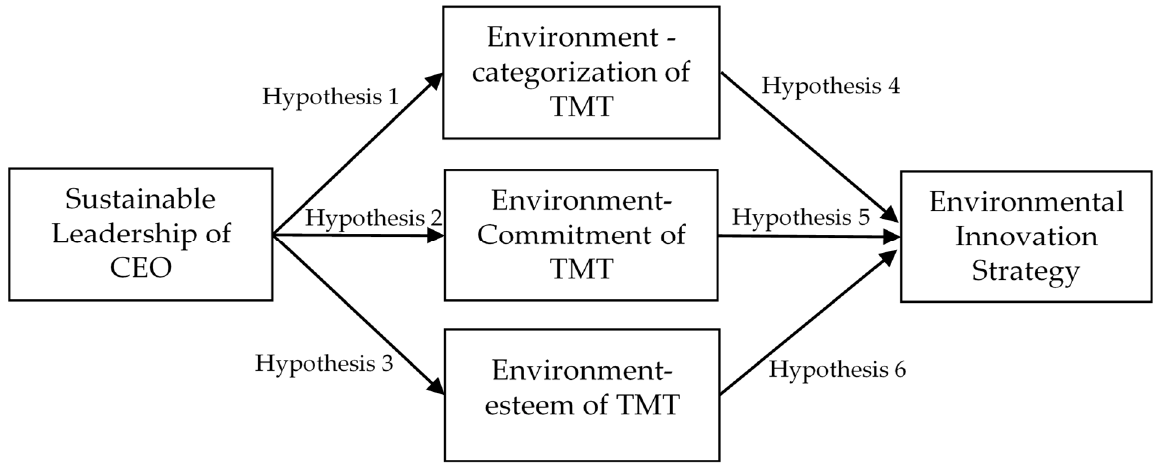
Figure 1. Research model of this